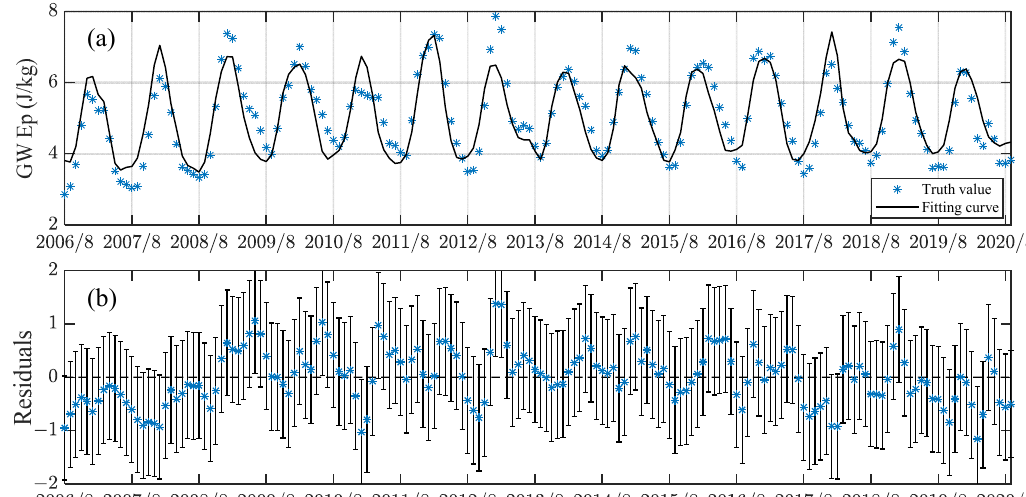
Figure 13. The GW Ep fitting curves ( a ) and the corresponding residuals ( b ) of multivariable linear regression model in the lower stratosphere over TP (25~41°N, 68~105°E) from August 2006 to Sep ‐